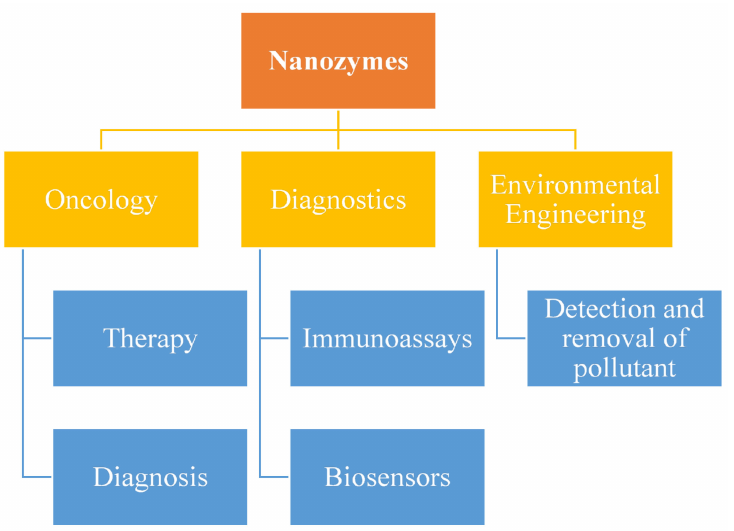
Figure 2. Opportunities in the field of